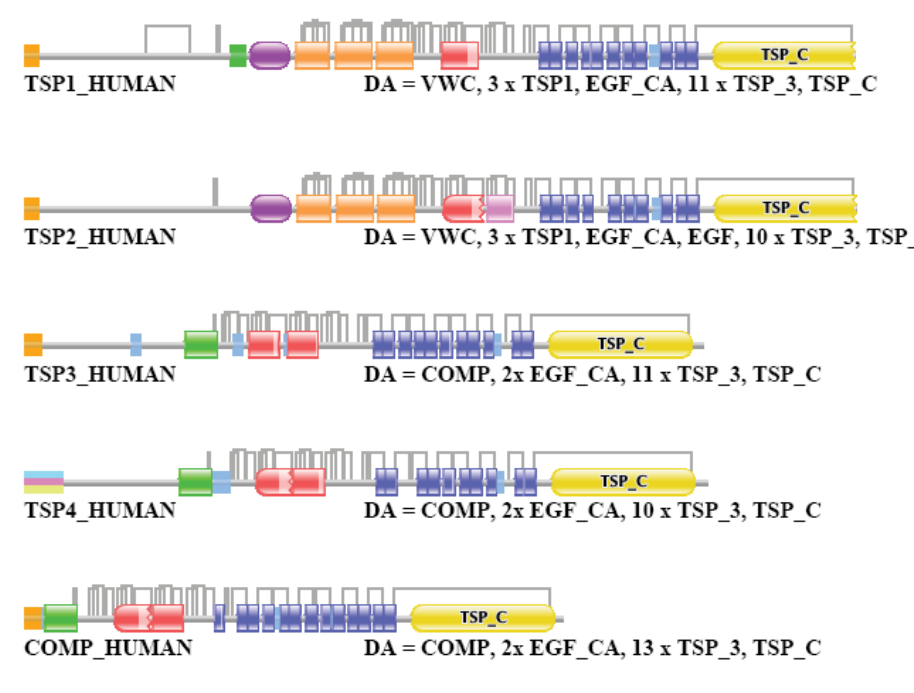
Figure S4. Comparison of the domain architectures of TSP2_HUMAN and its closest human